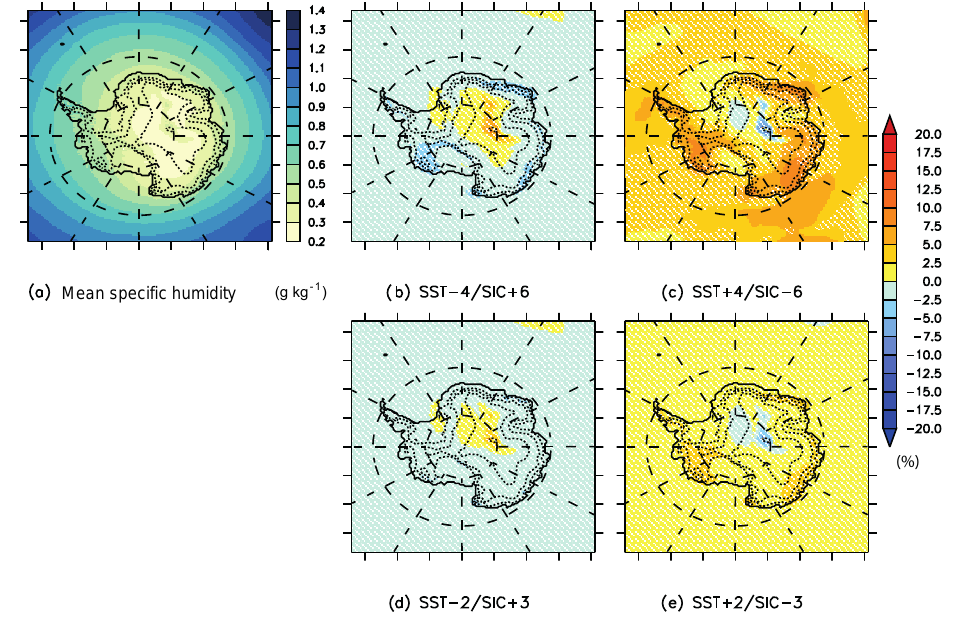
Figure 4. (a) Mean specific humidity modelled by MAR over 1979–2015 at 600hPa (units: gkg − 1 ). Difference in mean specific humidity (%) between the reference simulation and (b) SST − 4/SIC + 6, (c) SST + 4/SIC − 6, (d) SST − 2/SIC + 3, (e) SST + 2/SIC − 3 experiments. Differences lower than the interannual variability are considered as non-significant and are shown by dashed